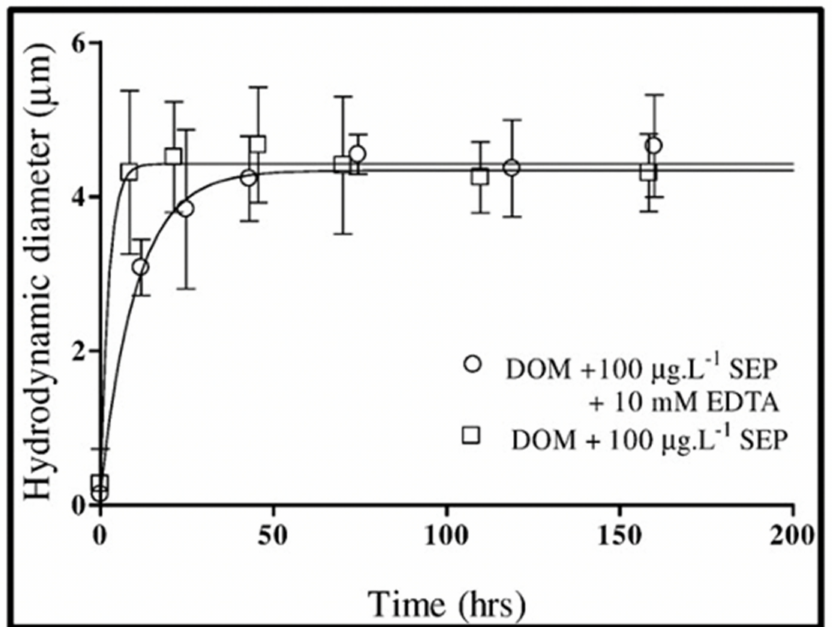
Figure 18. Kinetics of self-assembly of DOM polymers induced by adding 100 µ g × L − 1 SEP to 0.2 µ m-filtered seawater in the absence (open circles) or presence of 10 mM Ca 2+ chelator EDTA (open squares) does not exhibit significant statistical differences. Points are the average ± SD of 15 outcomes of triplicate measurements by DSL in five